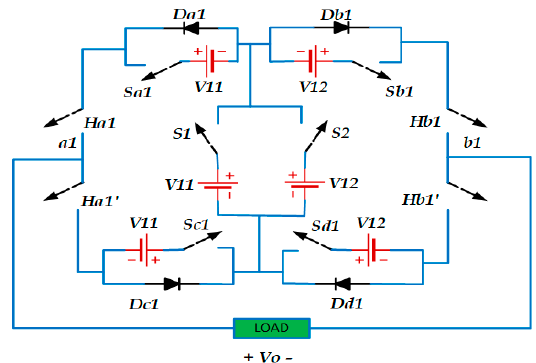
Figure 4. 17 − Level MLI.